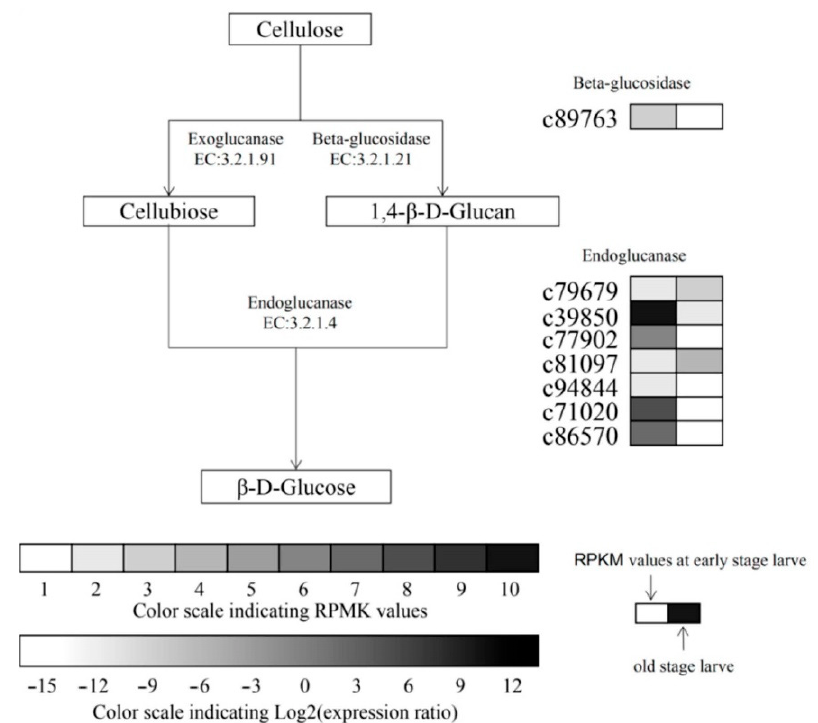
Figure 1. Di ff erential transcriptional levels of cellulolytic genes in di ff erent developmental stages in M. alternatus . The expression pattern of each transcriptome was shown on two grids, the RPKM values of the early larvae on the left and the relative log2 (expression ratio) of the later larvae on the right. The absolute expression range of early larvae is displayed with 10 di ff erent gray scale levels, and the RPKM values are 0–10, 10–20, 20–50, 50–100, 100–200, 200–400, 400–1000, 1000–2000, 2000–3000 and 3000–4000, respectively represented by scale 1–10.